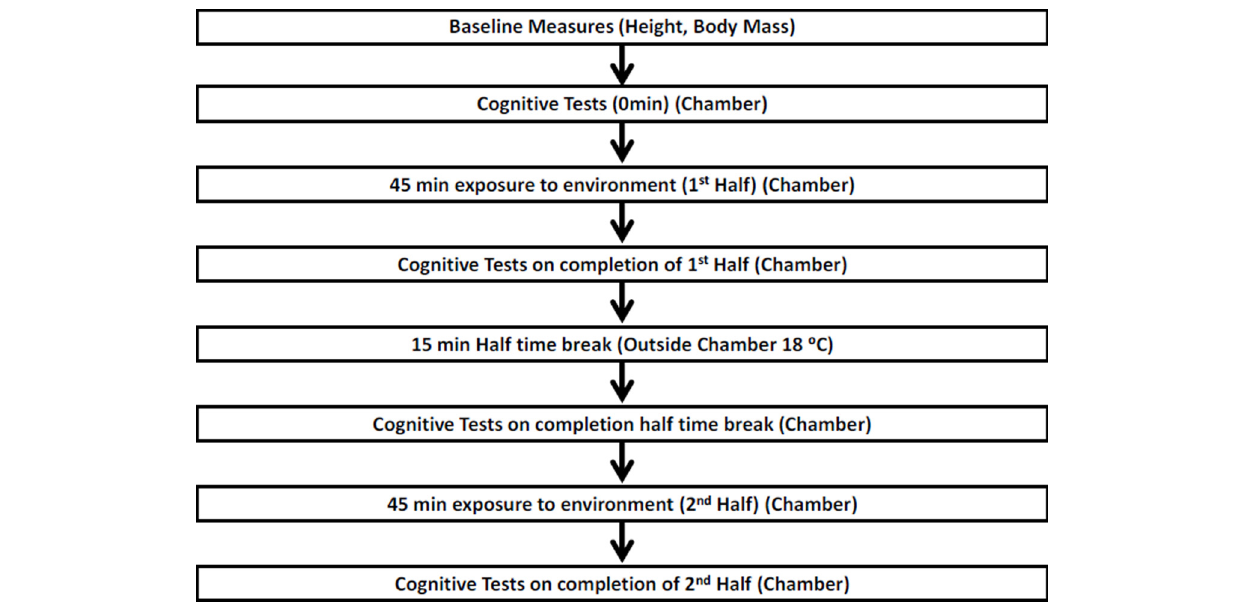
FIGURE 1 | Schematic of the 90min experimental procedure which was carried out in all 3 conditions.